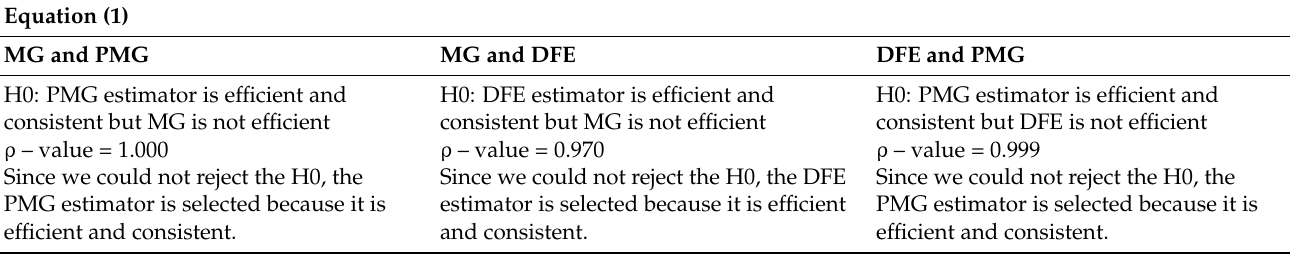
Table 12. Hausman tests for model